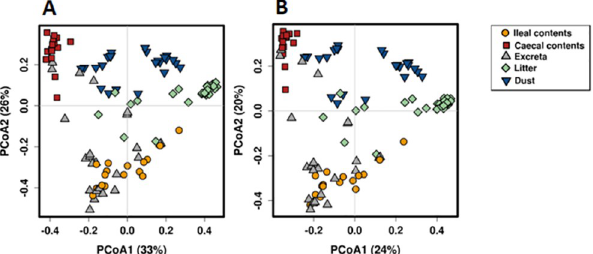
Fig 3. Principal coordinates analysis (PCoA) using Bray-Curtis (A) and Jaccard distance metric (B) showing the difference in the microbial community between caecal and ileal contents, dust, excreta and litter samples.